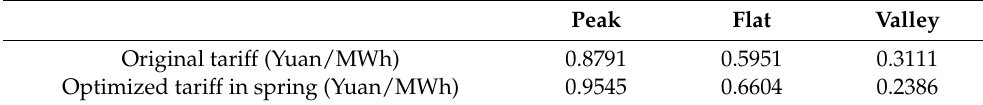
Table 6. The TOU tariff optimization results in autumn.